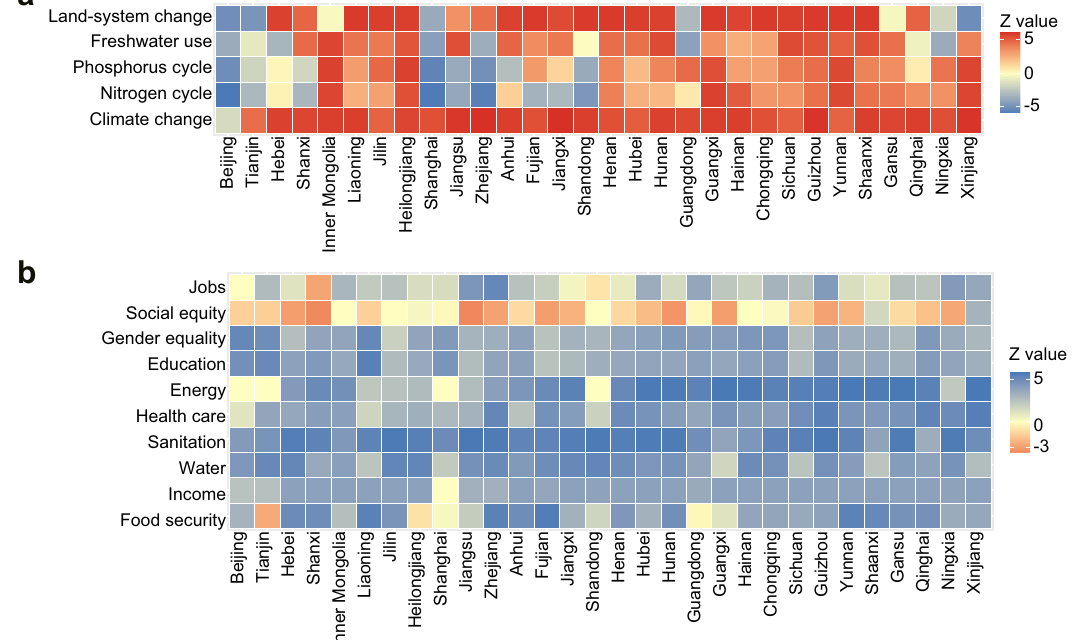
representing provinces with negative changes and blue color representing pro- vinces with positive changes. Speci fi cally, negative changes in environmental per- formance and human well-being represent increase in footprints and decrease in social indicators, respectively. The given signi fi cance level α is 0.05.